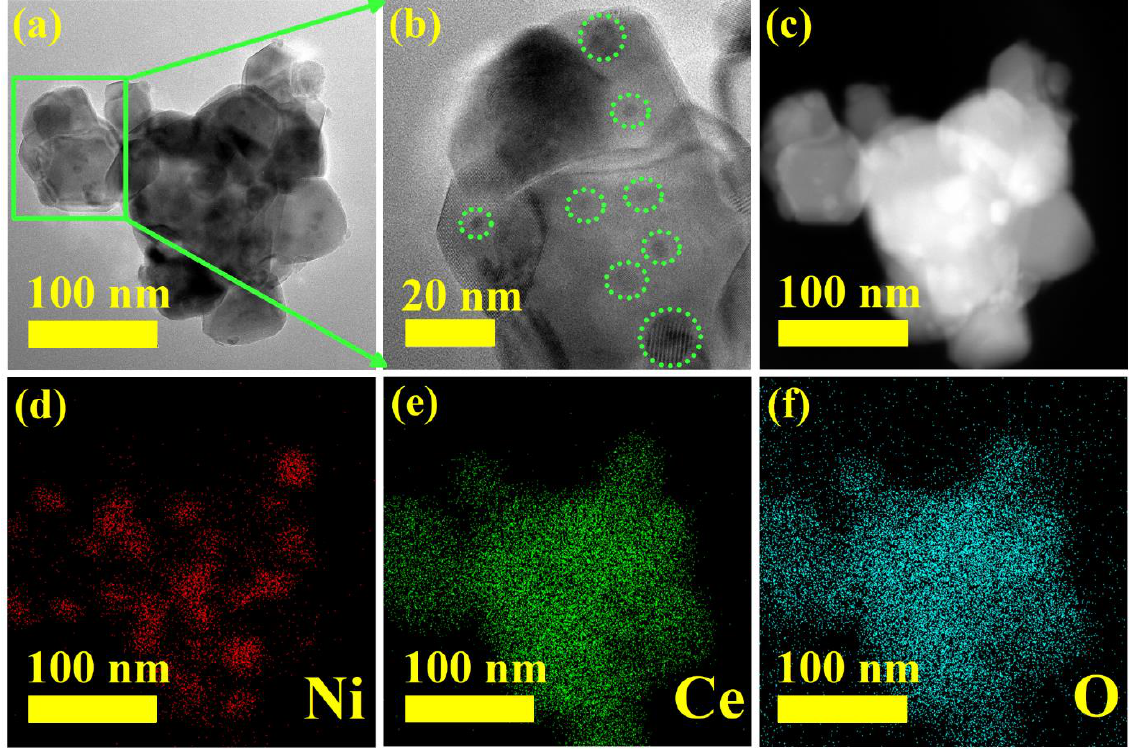
Figure 3. TEM ( a , b ), HAADF-STEM ( c ), and corresponding energy-dispersive X-ray elemental mapping images ( d – f ) of the reduced Ni@CeO 2 /7.5 catalyst. The green dotted circles in ( b ) highlight some of the Ni-NPs on CeO 2 support.